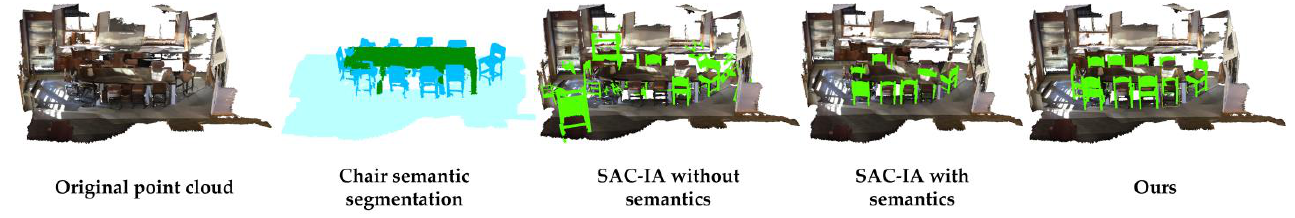
Figure 15. Comparison of different registration methods.